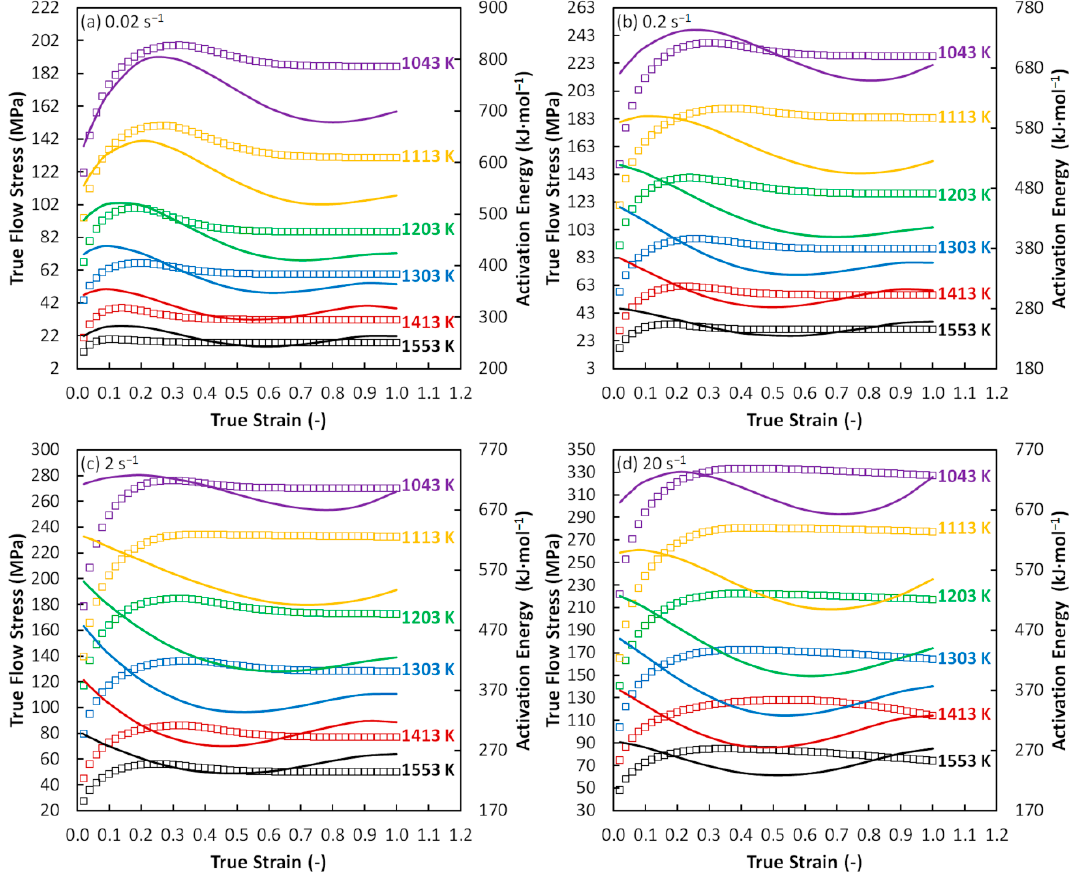
Figure 7. Correlation between the activation energy and flow stress course. ( a ) Strain rate of 0.02 s − 1 ; ( b ) strain rate of 0.2 s − 1 ; ( c ) strain rate of 2 s − 1 ; ( d ) strain rate of 20 s − 1 . Boxes–experimental flow curves; solid lines–activation energy evolution.